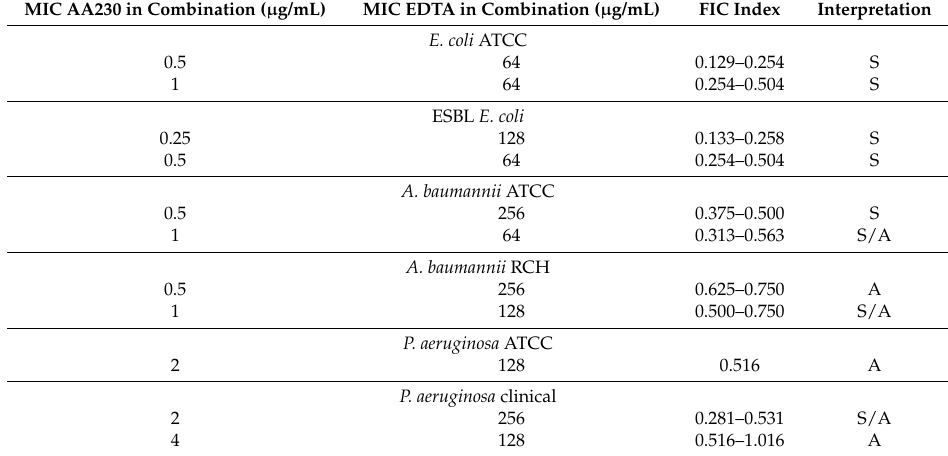
Table 2. Minimum inhibitory concentrations (MICs) and fractional inhibitory concentration (FIC) indexes of antimicrobial peptide AA230 and EDTA in combination against different strains of P. aeruginosa , A. baumannii and E. coli . MICs are expressed in µ g/mL. S: synergy; A: additivity. MIC AA230 in Combination ( µ g/mL) MIC EDTA in Combination ( µ g/mL) FIC